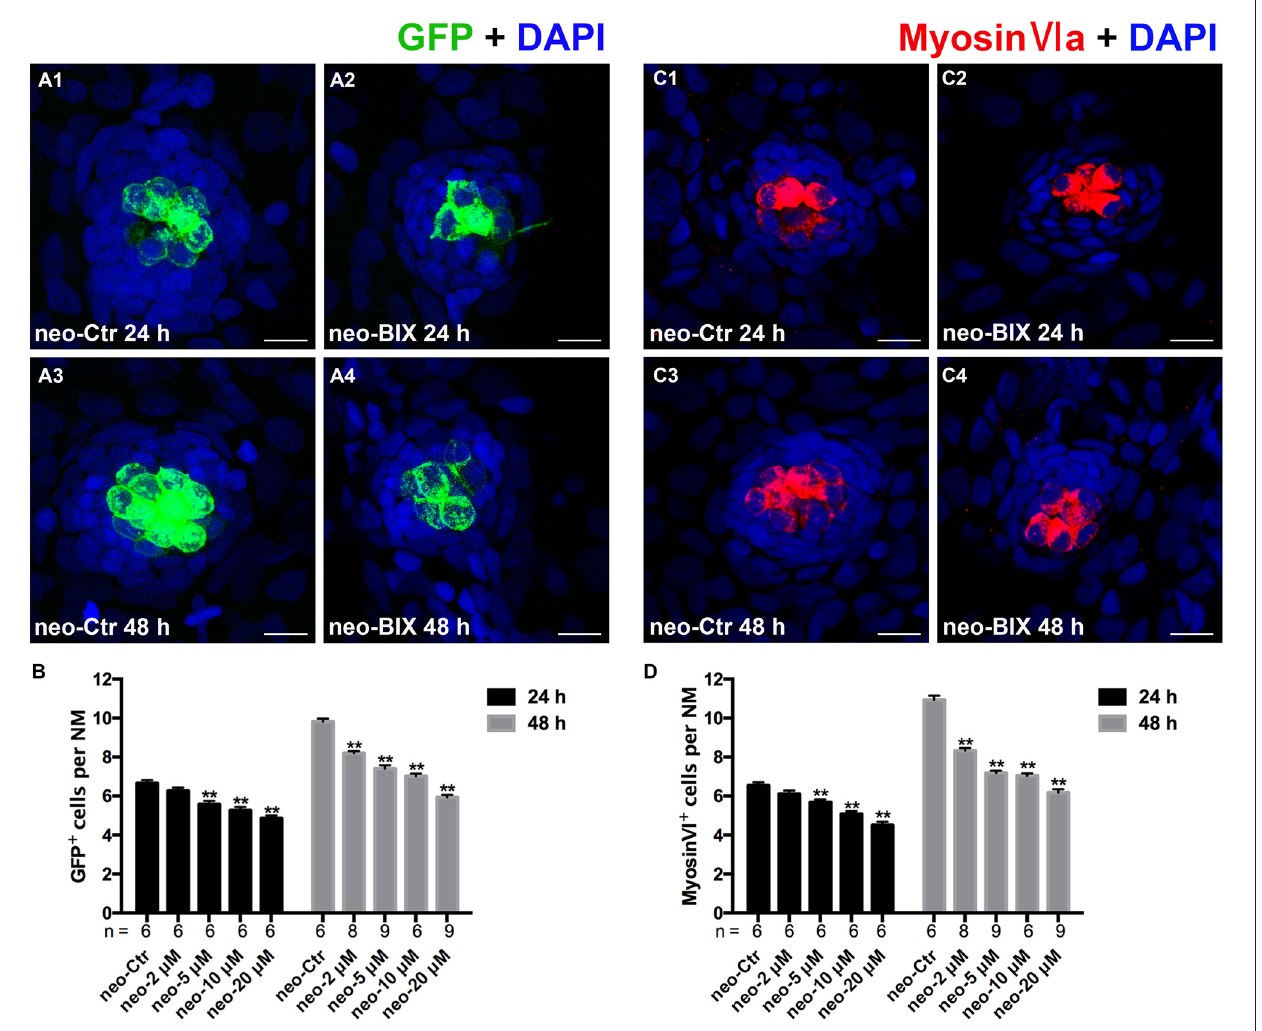
FIGURE 2 | BIX01294 treatment reduces HC regeneration in the zebrafish lateral line. (A) We treated 5 days post-fertilization (dpf) Tg (brn3c:mGFP) zebrafish with neomycin for 1 h and then treated them for 24 h or 48 h with BIX01294. HCs in these fish are GFP + (green), and nuclei are stained with DAPI (blue). Scale bars = 10 µ m. (B) The average number of GFP + cells per NM in larvae treated with or without 20 µ M BIX01294 for 24 h or 48 h after neomycin damage for 1 h. Bars are mean ± SEM, and n = total number of embryos. ∗∗ p < 0.001. (C) We treated 5 dpf wild-type zebrafish with neomycin for 1 h and then treated them for 24 h or 48 h with BIX01294, and HC-specific Myosin-VI immunostaining (red) was used to label HCs. Nuclei are stained with DAPI (blue). Scale bars = 10 µ m. (D) The average number of Myosin-VI + cells per NM in larvae treated with or without 20 µ M BIX01294 for 24 h or 48 h after neomycin damage for 1 h. Bars are mean ± SEM, and n = total number of embryos. ∗∗ p <